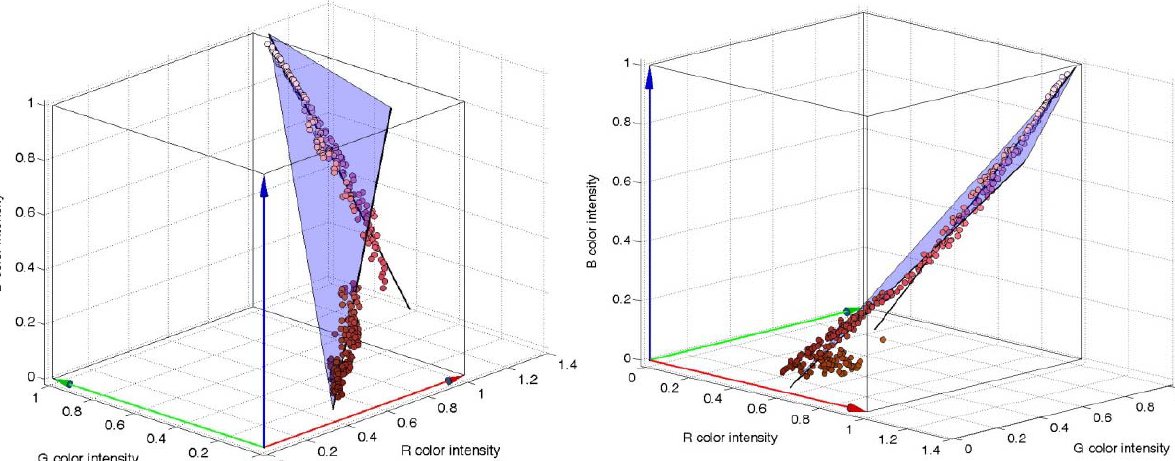
Figure 4. Two additional views of the PEACH A and B areas (Figure 3) plotted with a regression line and an auxiliary plane plotted to illustrate the relationship of both regression